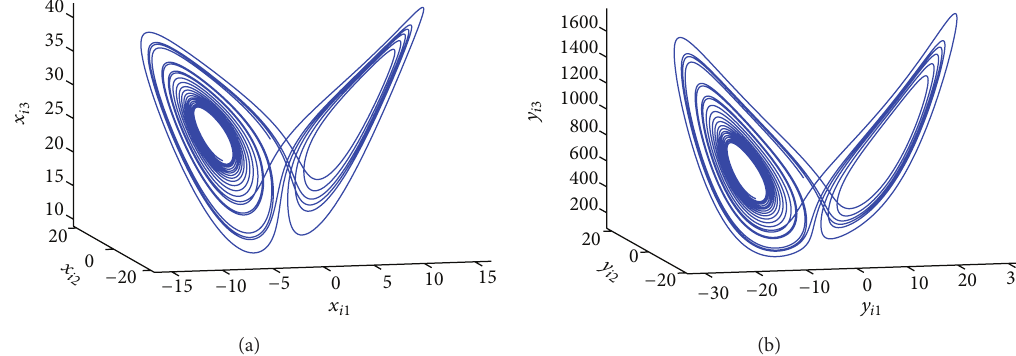
Figure 5: The phase diagrams for node 3 in the drive and response networks consisting of identical Lorenz systems, with the functional relations being y 𝑖 = (2𝑥 𝑖1 ,𝑥 𝑖1 + 1, 𝑥 2 𝑖3 ) . (a) Node 3 in the drive network; (b) node 3 in the response network.